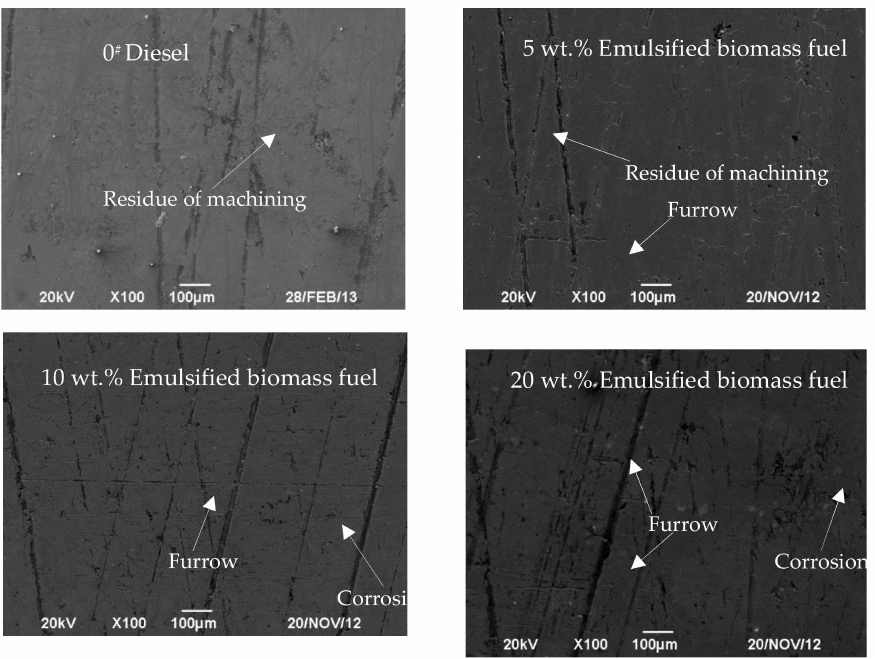
Figure 5. SEM images of the surface of the lower cylinder liner lubricated by the emulsified biomass fuel with different ratios.